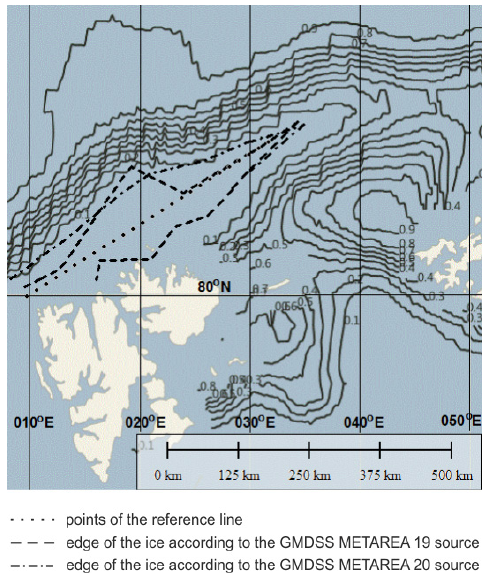
Fig. 5. Map of sea ice concentration in GRIB format (visualization using Meteo Explorer